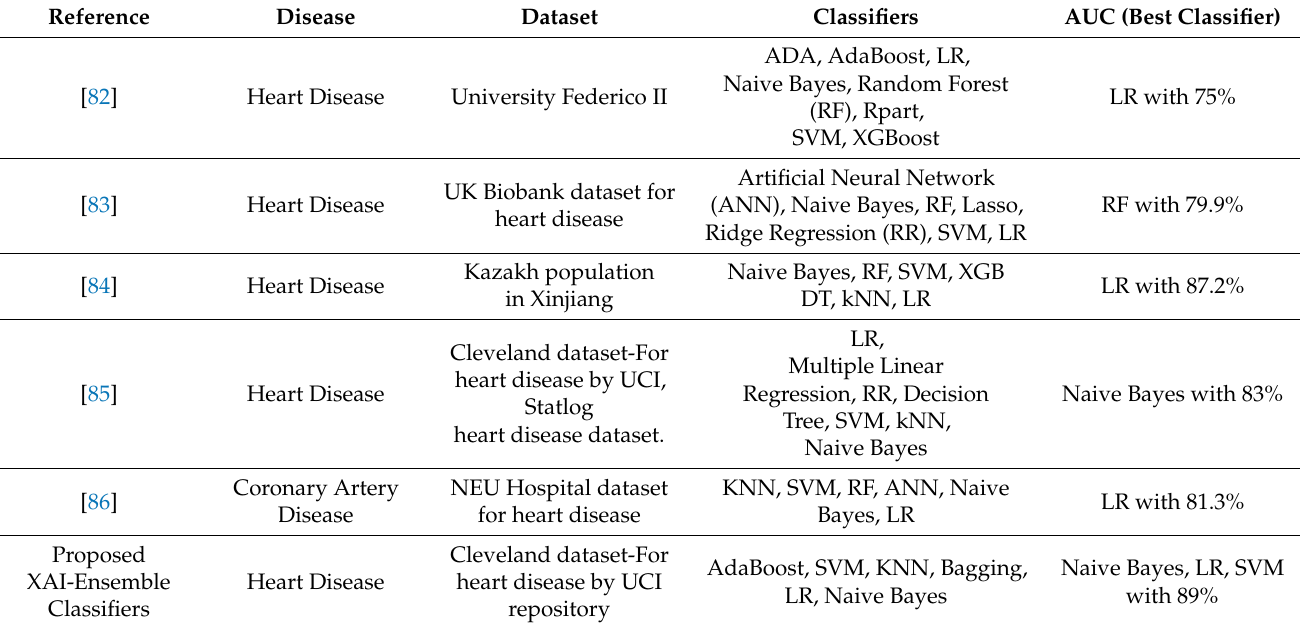
Table 6. Comparison of the area under the curve (AUC) value of the various ensemble